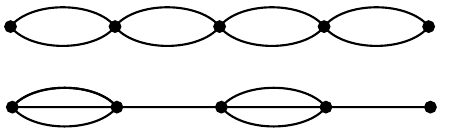
Figure 7. Toy model of a chain of springs in 1-D. Each line represents a spring of equal stiffness k . The more heterogeneous bottom system with stiffer clusters is globally less stiff than the regular chain. Note that the connectivity and the number of springs is the same in both